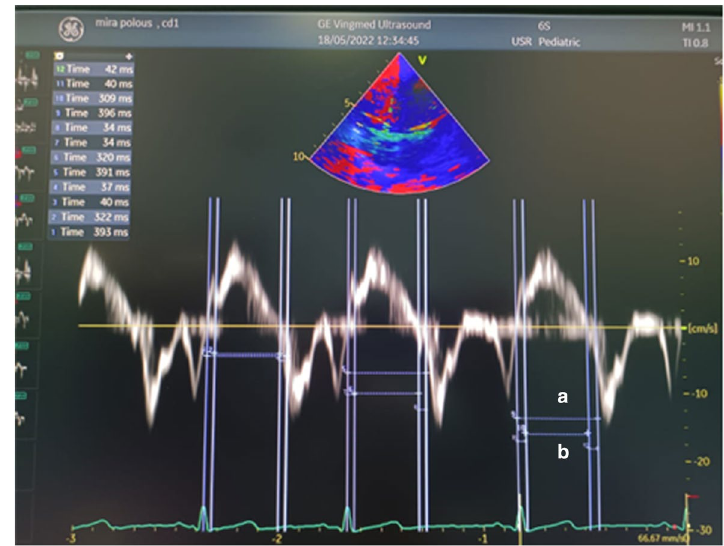
Fig. 1 Calculation of MPI by tissue Doppler imaging. MPI, myocardial performance